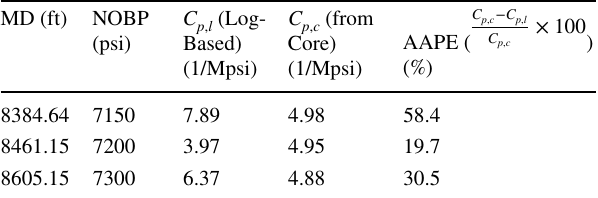
Table 4 Log-based compressibility vs core pore compressibility val- ues for Asmari carbonate, Southwest Iran. The core compressibility data is for reliable well log